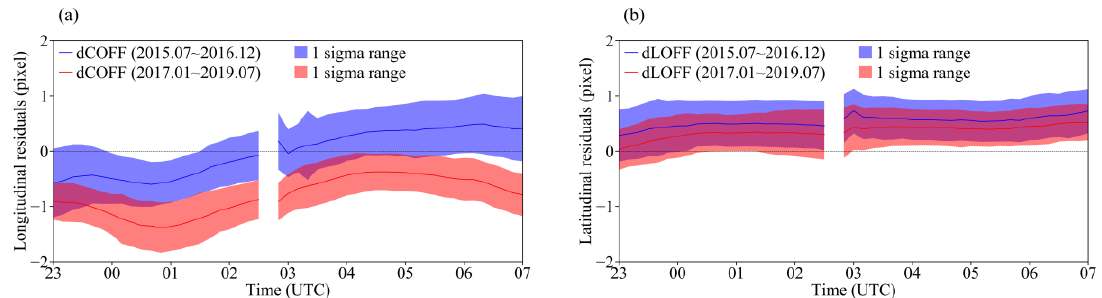
Figure 5. Diurnal changes of mean values and 1 sigma ranges of ( a ) dCOFF and ( b ) dLOFF at each observation time for two periods, from July 2015 to December 2016 (blue) and from January 2017 to July 2019 (red). The data at 02:40 UTC are missing due to routine satellite housekeeping.